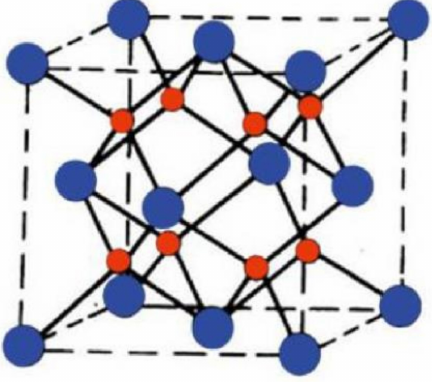
Figure 1. The structure of an alumina